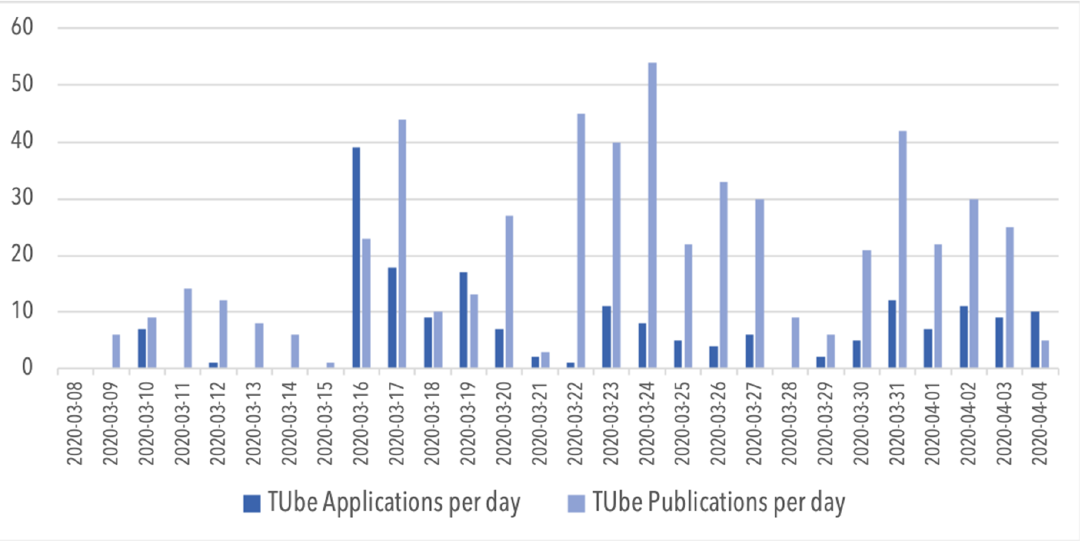
Figure 7. Sum of new applications and publications per day on TUbe from 8th of March to 4th of April